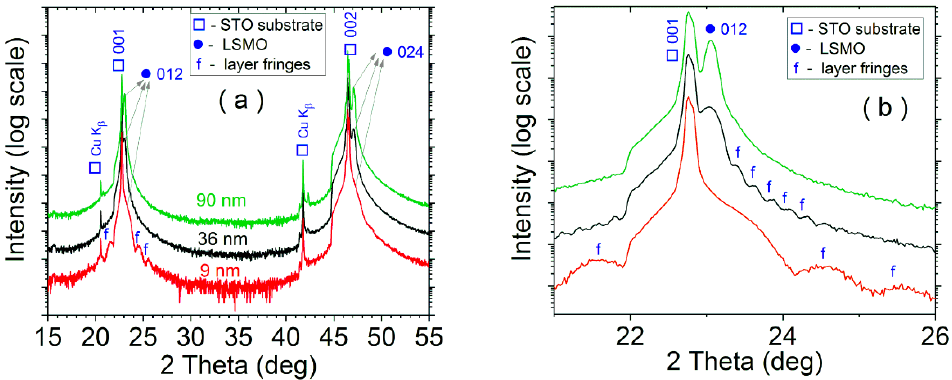
Figure 1. X-ray diffraction patterns of the LSMO samples: 9, 36, and 90 nm ( a ). Enlarged view of the layer fringes ( b ).